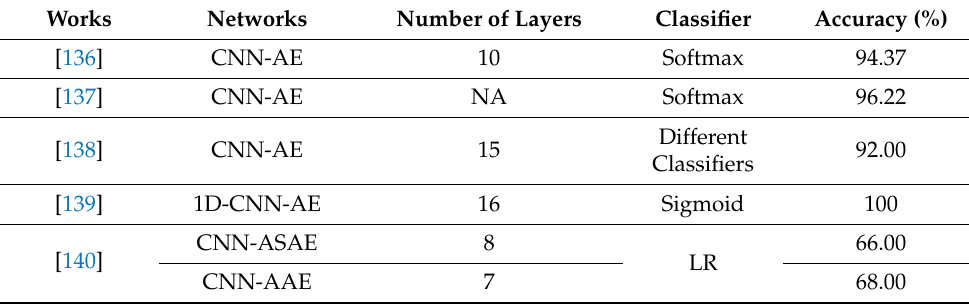
Table 7. Summary of related works done using